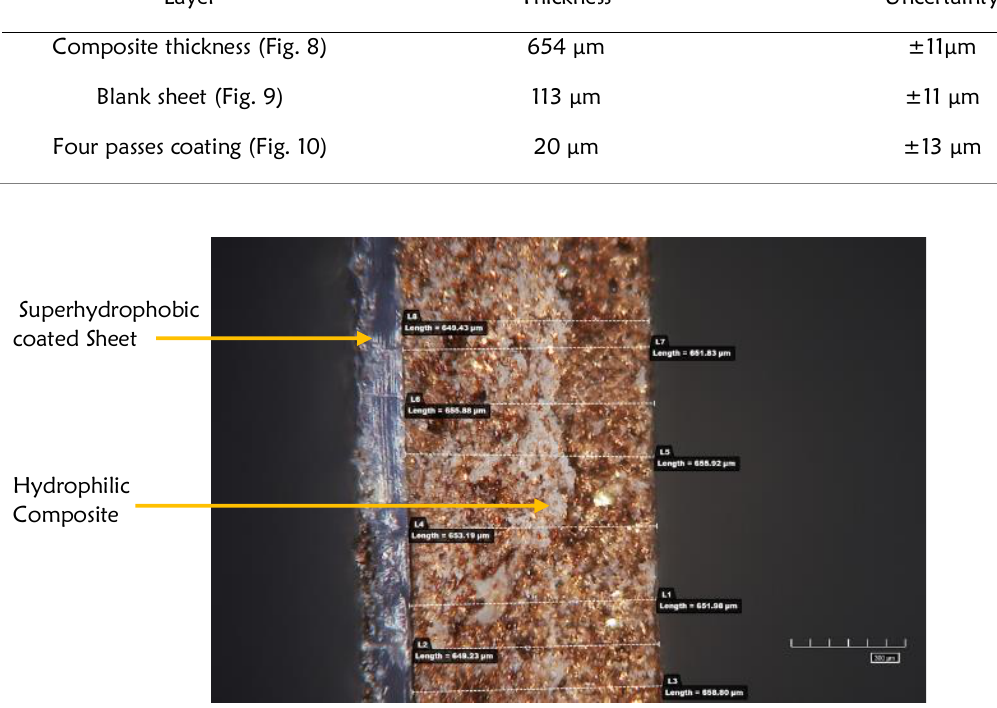
Figure 8: The coating was measured using the Hirox digital microscope. The coating on the glasses performed with the same conditions as on the